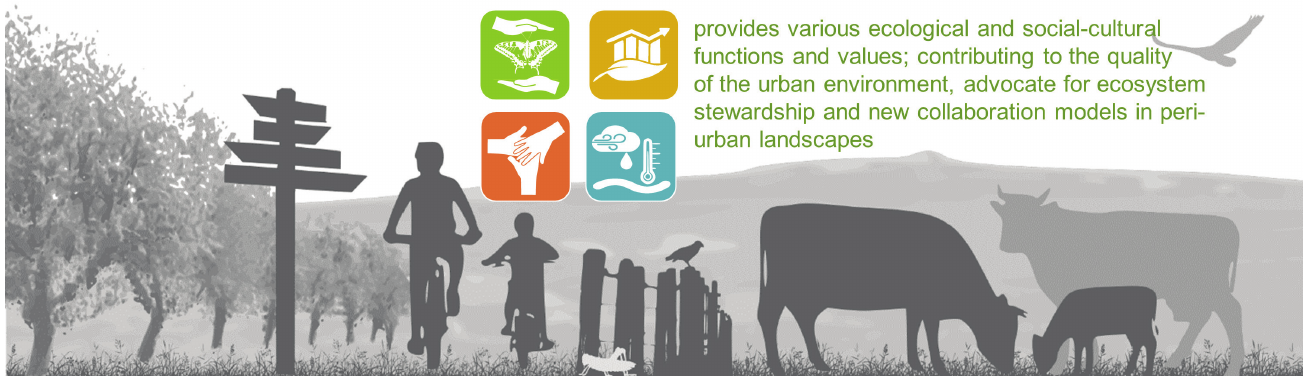
Figure 7. Illustration of semi-natural farmland with potential key functions and benefits addressing urban challenges.